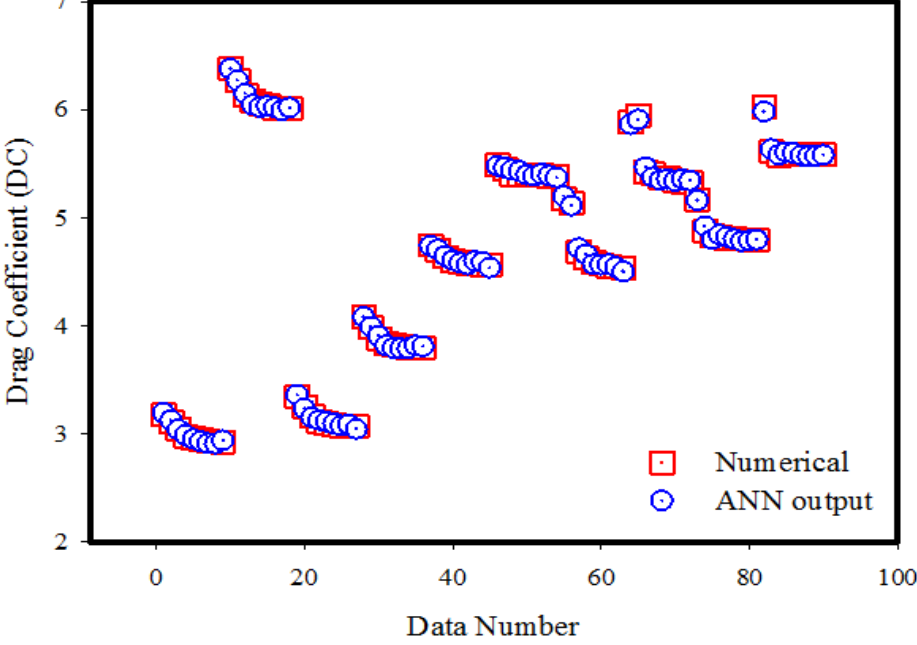
Figure 8. The correspondence of the DC values obtained from the MLP neural network and the numerical data.